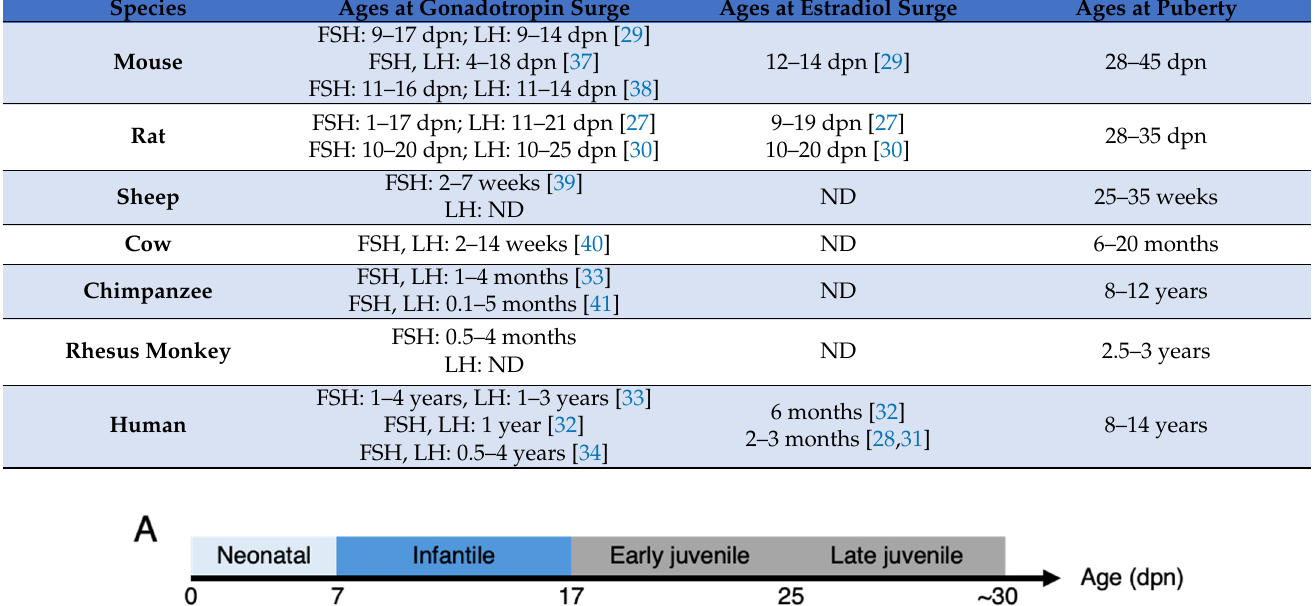
Table 1. Approximate ages of HPO activation and puberty in humans and different mammal species. ND: not determined.